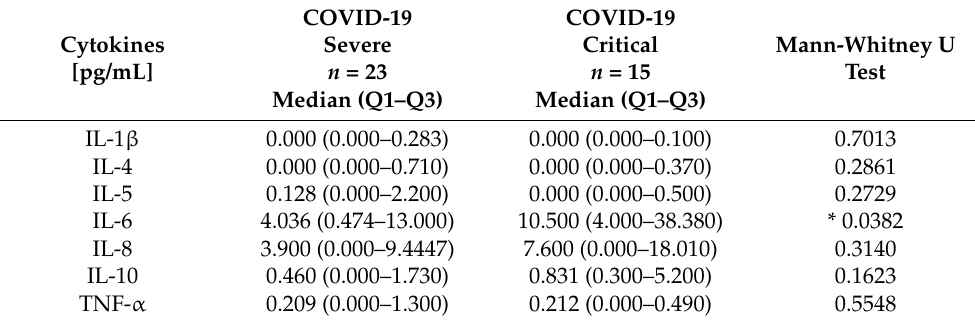
Table 3. Differences in the median of cytokine levels in patients with severe and critical COVID-19. Data expressed as median (Q1 – Q3). * p < 0.05.